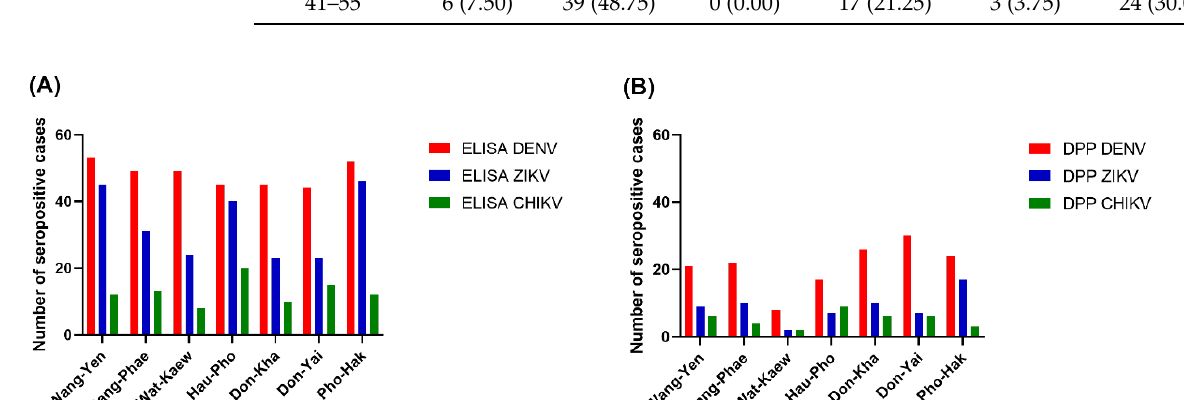
Figure 2. Seroprevalence of three arboviruses by age group. ( A ) The ELISA results; ( B ) The DPP ® ZCD IgG results. The x-axes describe the DENV (red), ZIKV (blue), and CHIKV (green) distributions for five age groups in Bangphae district, Ratchaburi province, Thailand. The y-axes represent the seroprevalence, as shown by the number of cases.